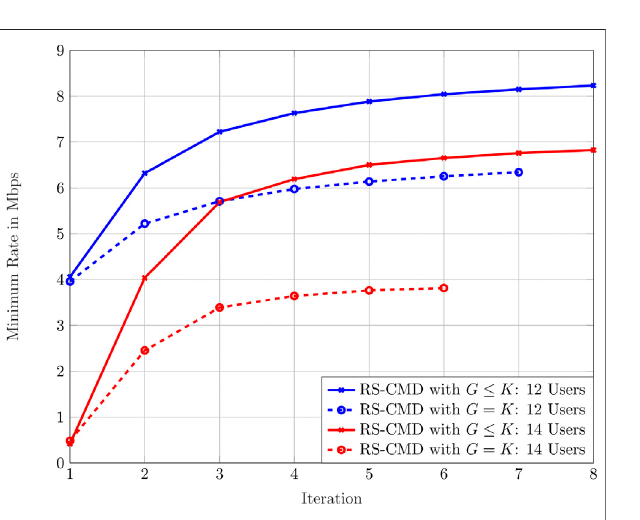
FIGURE 7 | Convergence behavior of the proposed algorithm under statistical CSIT. Two different numbers of users are considered for RS-CMD with G ≤ K and G (cid:3) K